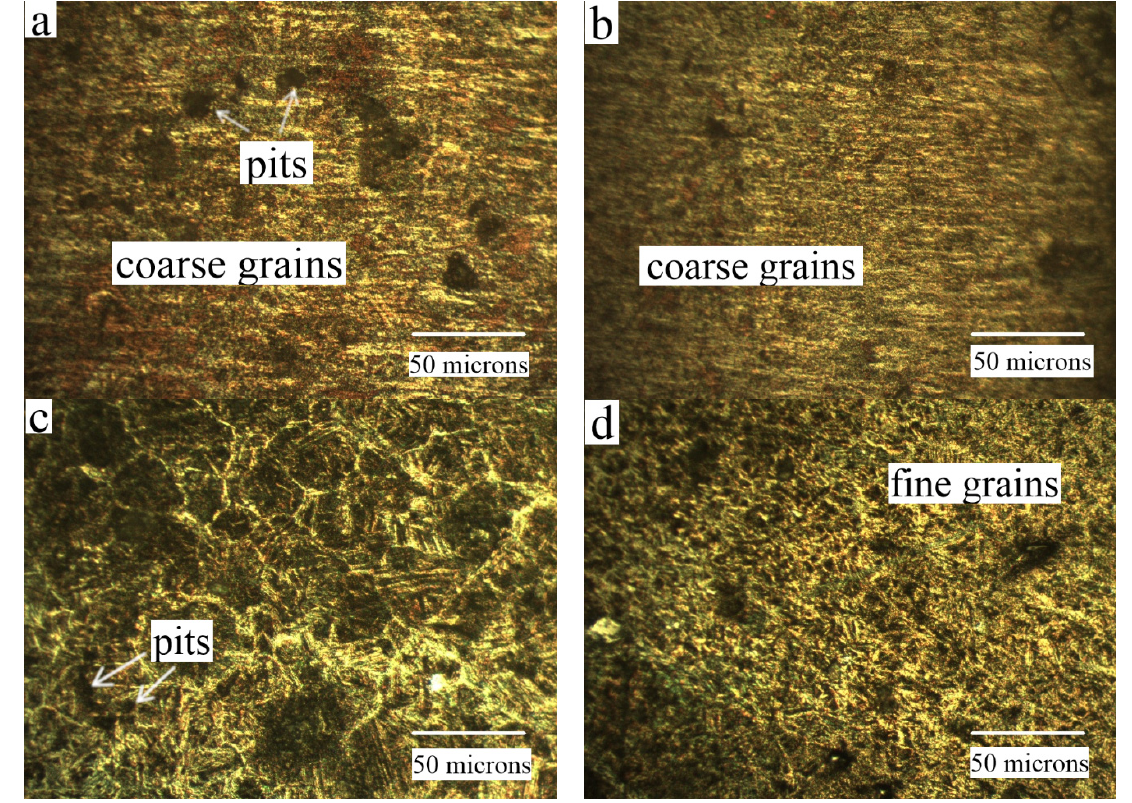
Figure 12. Optical micrograph of slurry erosion–corrosion for ( a ) as-cast NAB at 30°, ( b ) as-cast NAB at 90°, ( c ) FSPed composite at 30°, and ( d ) FSPed composite at 90°.